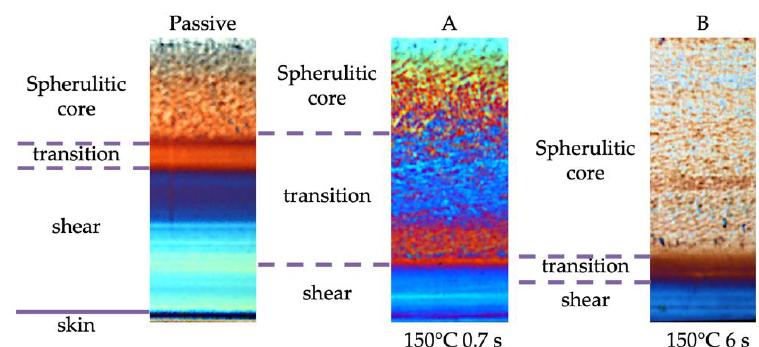
Figure 3. Optical micrographs of the molded samples obtained with different cavity surface temperature evolutions, from left to right: Passive, 150 °C kept for 0.7 s and 150 °C kept for 6 s (see Table 1 for the operating conditions). The slices were cut along the flow-thickness plane, and only half-thickness was shown.